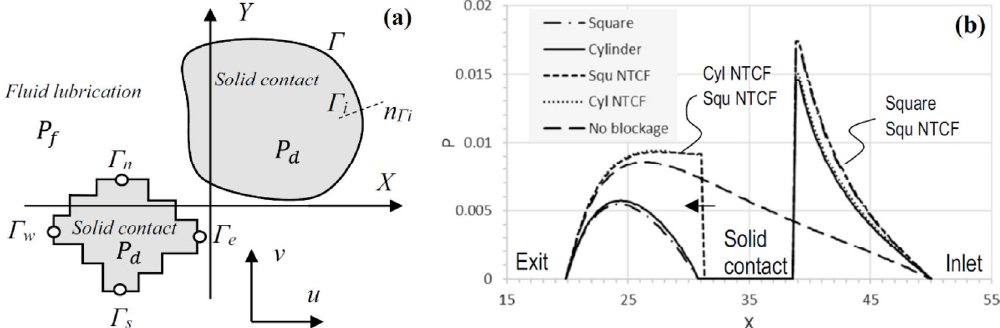
Fig. 49 A point-contact lubrication problem. (a) Simulation region with lubrication–contact interfaces and (b) comparison of pressures. The “NTCF” with the 1B scheme allows the Couette flow exchange (see arrows) when the fluid lubrication zone is on the left-hand side of the solid-contact zone [850]. Reproduced with permission from Ref. [850], © The author(s),